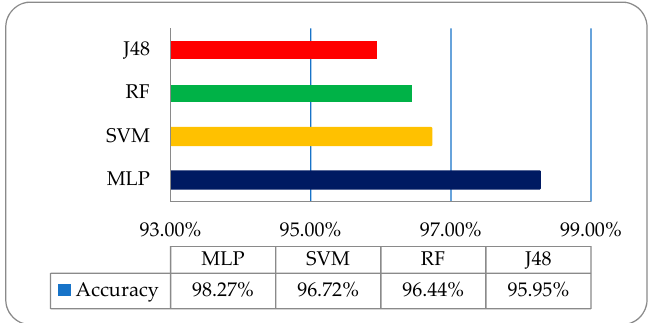
Figure 11. The overall accuracy graph of employed ML classifiers on Radiopaedia fused optimized public dataset.